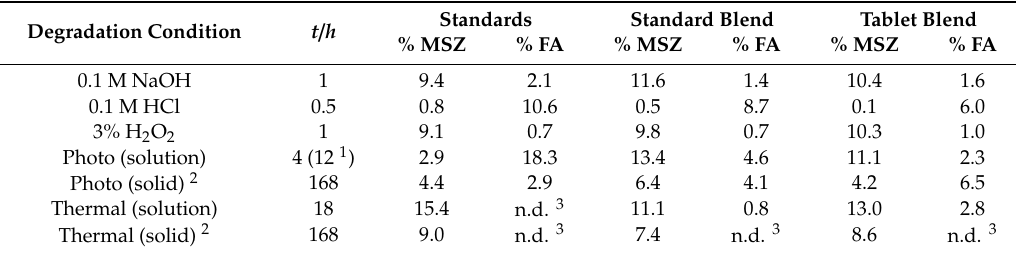
Figure 4. Overlapped chromatograms of stressed MSZ, FA and their combinations in: ( a ) alkali, ( b ) oxidative, ( c ) photo (solution), ( d ) photo (solid) and ( e ) thermal (solution) conditions. Table 3. Forced degradation study